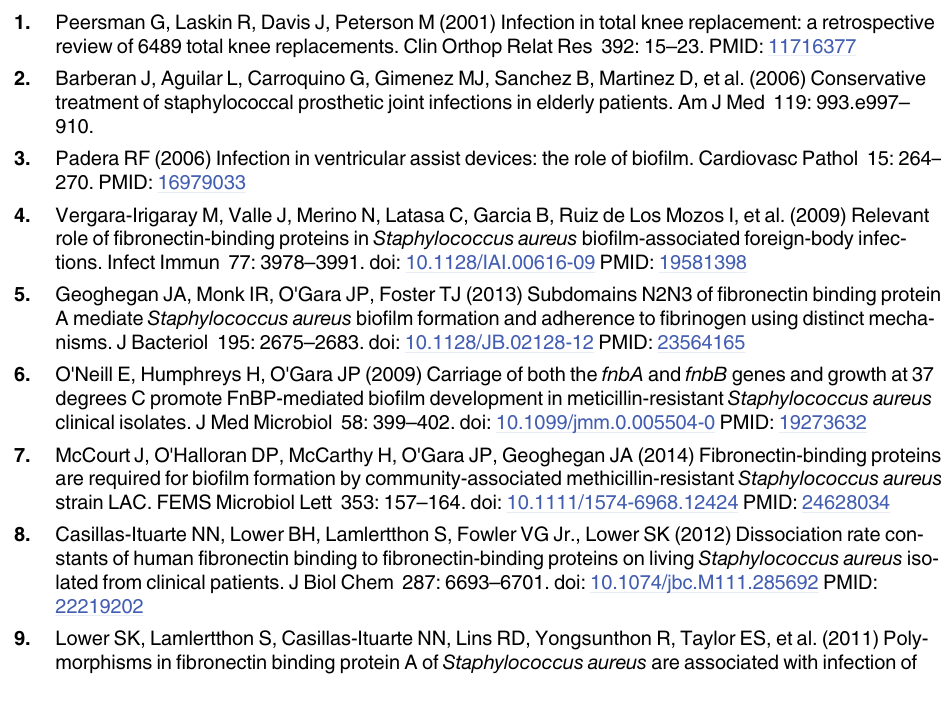
S1 Fig. Scatter plot of fibronectin binding capacity versus biofilm formation. Fibronectin binding capacity was normalized to that of control strain S . aureus 8325 – 4, and biofilm forma- tion was normalized to that of S . aureus